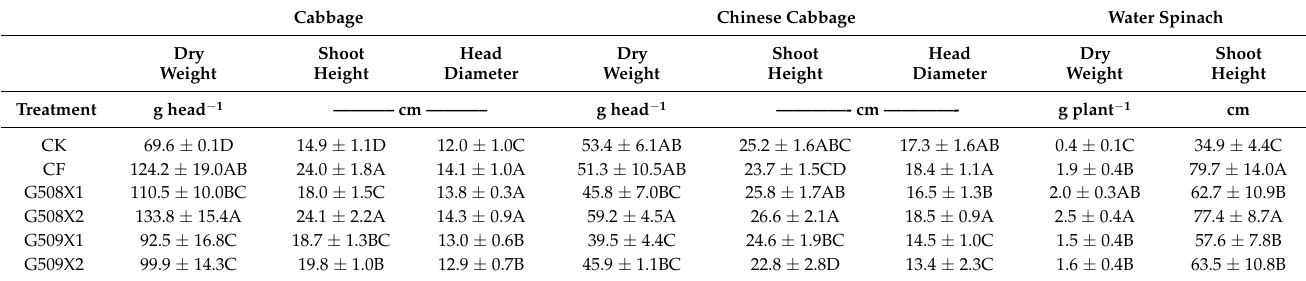
Table 2. The agronomic traits of cabbage, Chinese cabbage, and water spinach under different treatments. Cabbage Chinese Cabbage Water